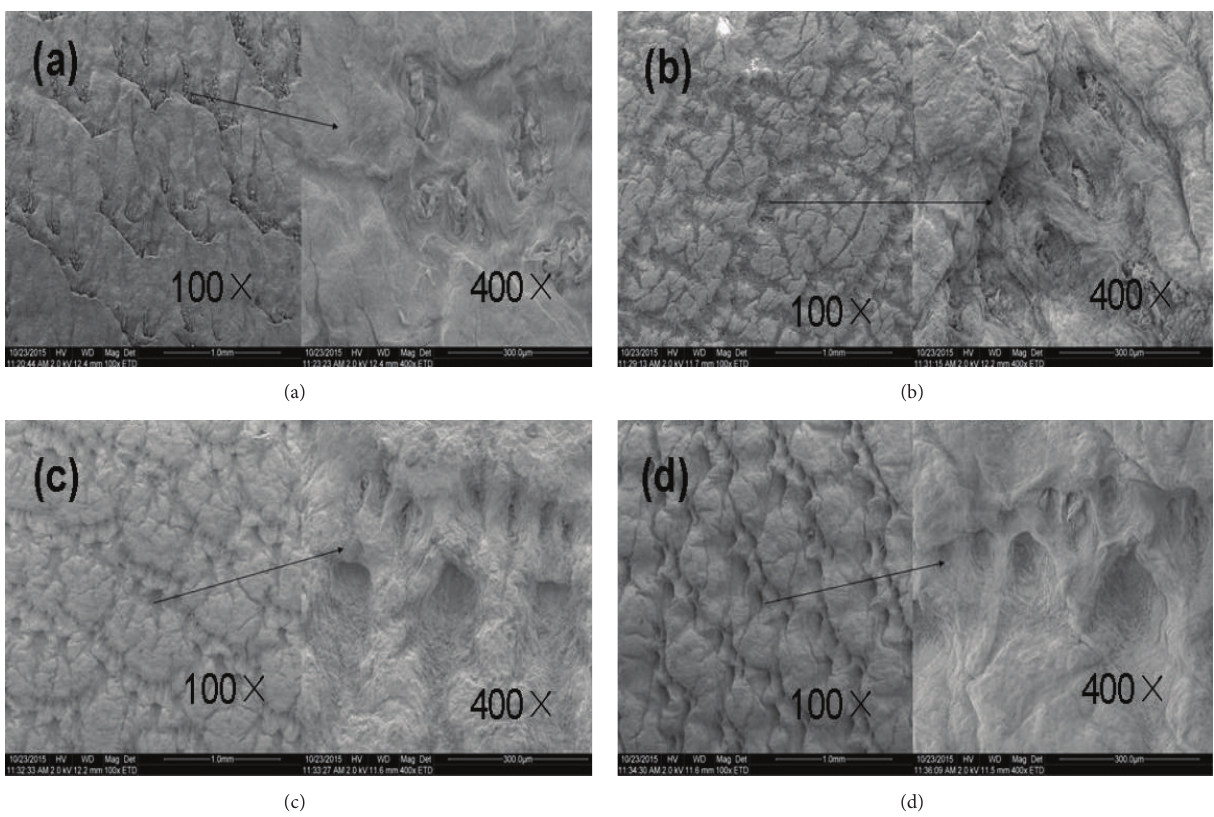
Figure 6: Scanning electron micrographs showing the grain surface (100x and 400x). (a) Tanned with chrome tanning agent prepared from the untreated chromium waste liquid. (b) Tanned with chrome tanning agent prepared from the chromium waste liquid treated with enzyme. (c)TannedwithchrometanningagentpreparedfromthechromiumwasteliquidtreatedwithFenton. (d)Tannedwithcommercialchromium